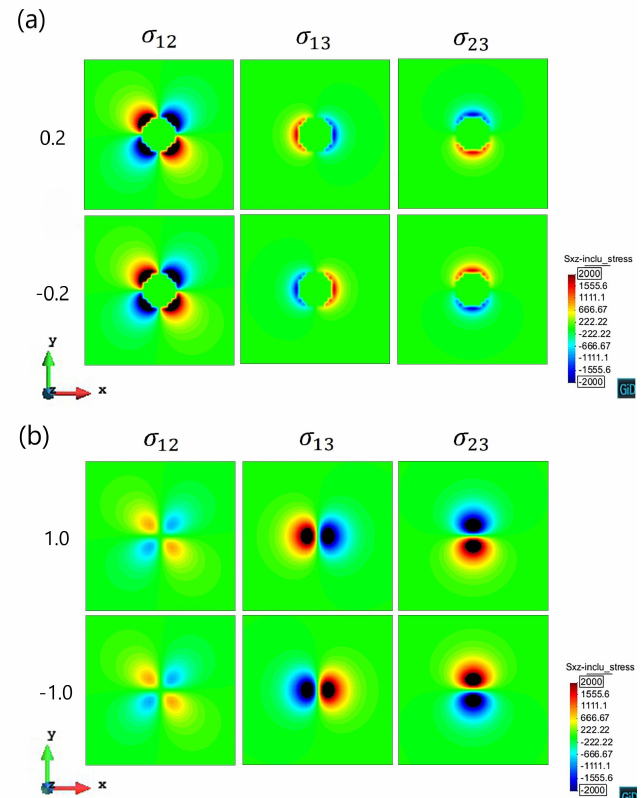
Figure 2. Contour plots of stress on the cross-section of the spherical precipitate ( a ) z / R = ± 0.2; ( b ) z / R = ±